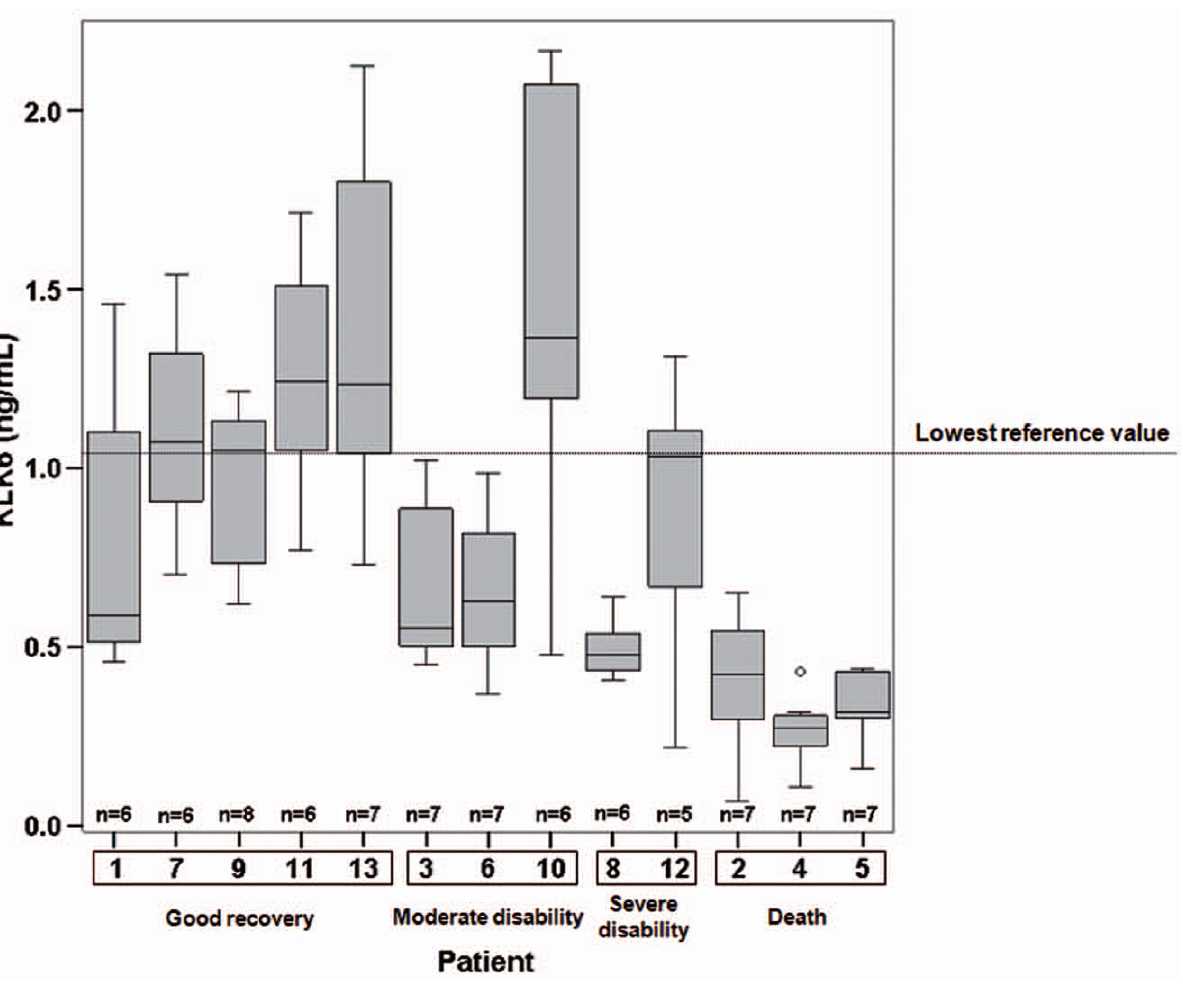
Figure 5. Box and Whisker diagram of serum kallikrein 6 levels (ng/mL) in patients with subarachnoid hemorrhage (n=13), within the first 56 hours. The number of samples for each patient varies from 5 to 8.